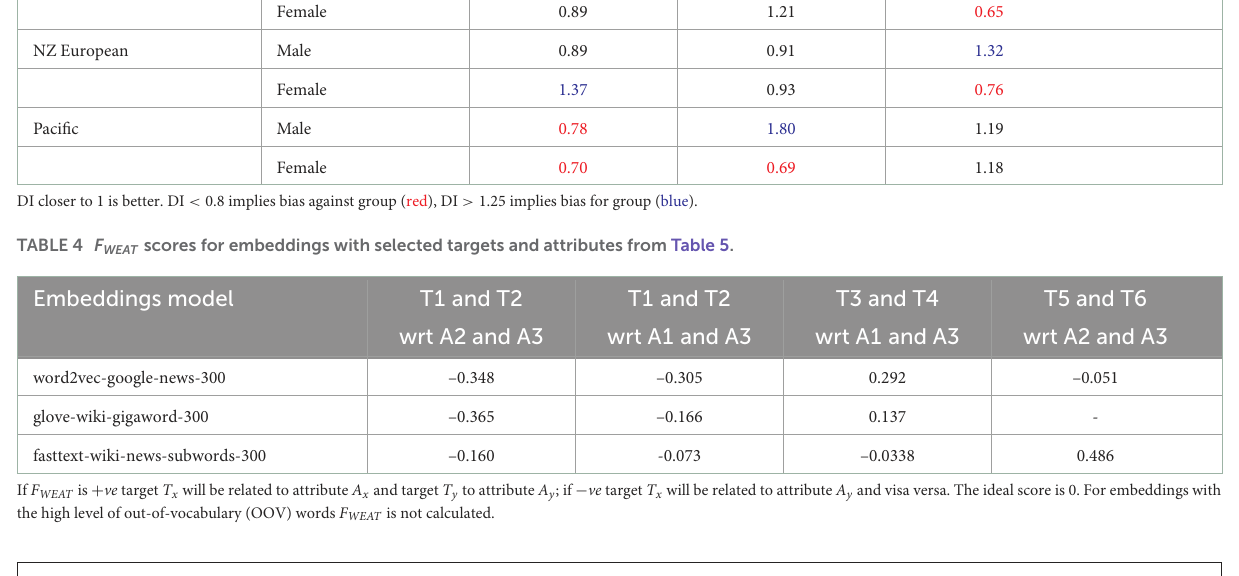
TABLE 3 Disparate Impact (DI) values of NZ-GP Harms data with targets: Harm Status and Preventable Harm Status, and NZ-GDF Data with targets: Hospital mortality. Protected groups’ ethnicity and gender are combined. Protected groups NZ-GP Data NZ-GDF data Ethnicity Gender Harm